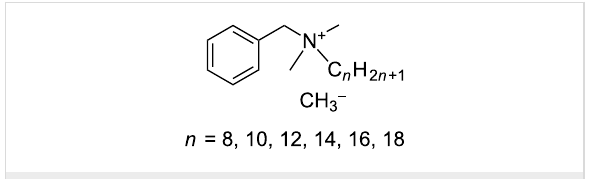
Figure 10: Chemical structure of benzalkonium